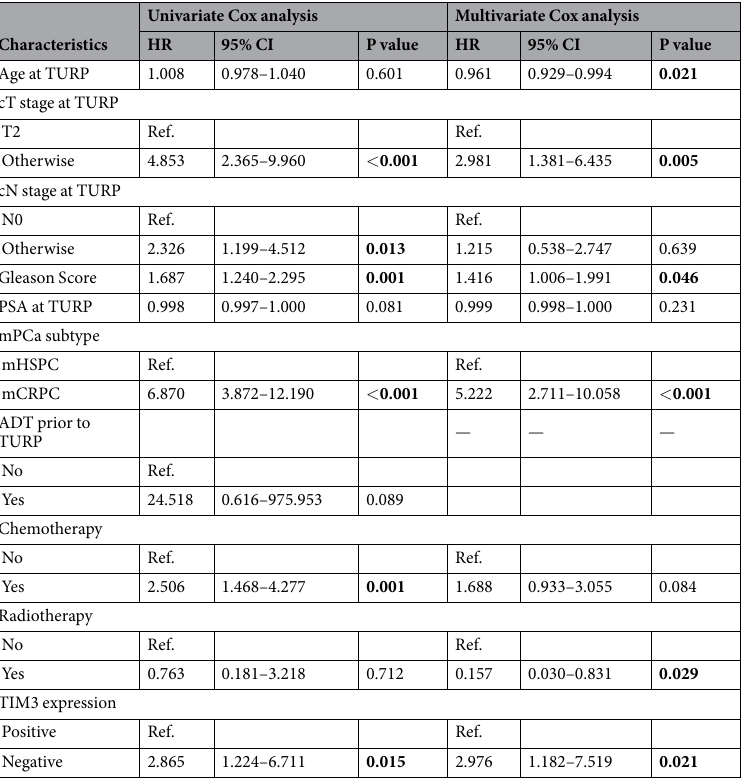
Table 2. Univariate and multivariate Cox regression analysis of overall survival in metastatic prostate cancer